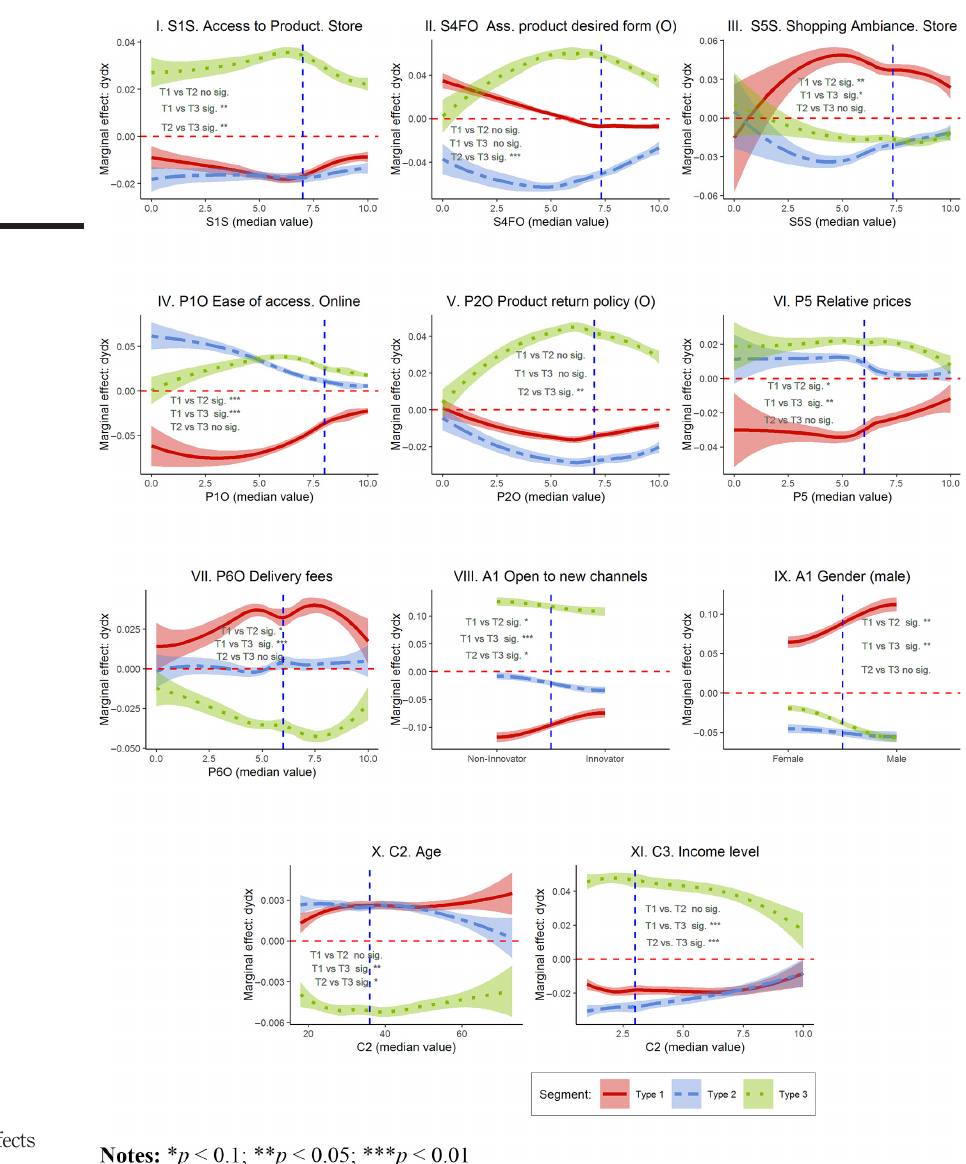
Figure 1. Marginal